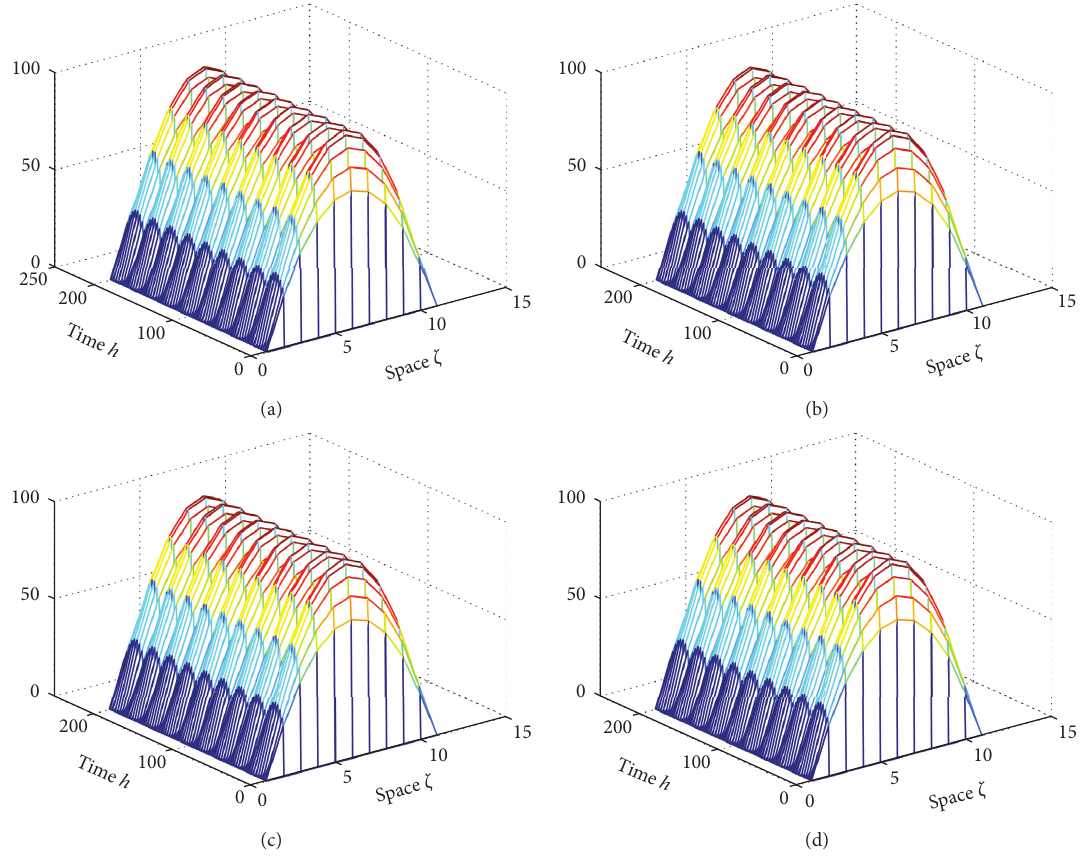
Figure 1: Actual output of three agents and the virtual leader agent in nonlinear hyperbolic partial MASs. (a) Virtual yτ ( ζ , h ). (b) Agent1 y 1( ζ , h )( k � 30). (c) Agent2 y 2( ζ , h )( k � 30). (d) Agent3 y 3( ζ , h )( k �